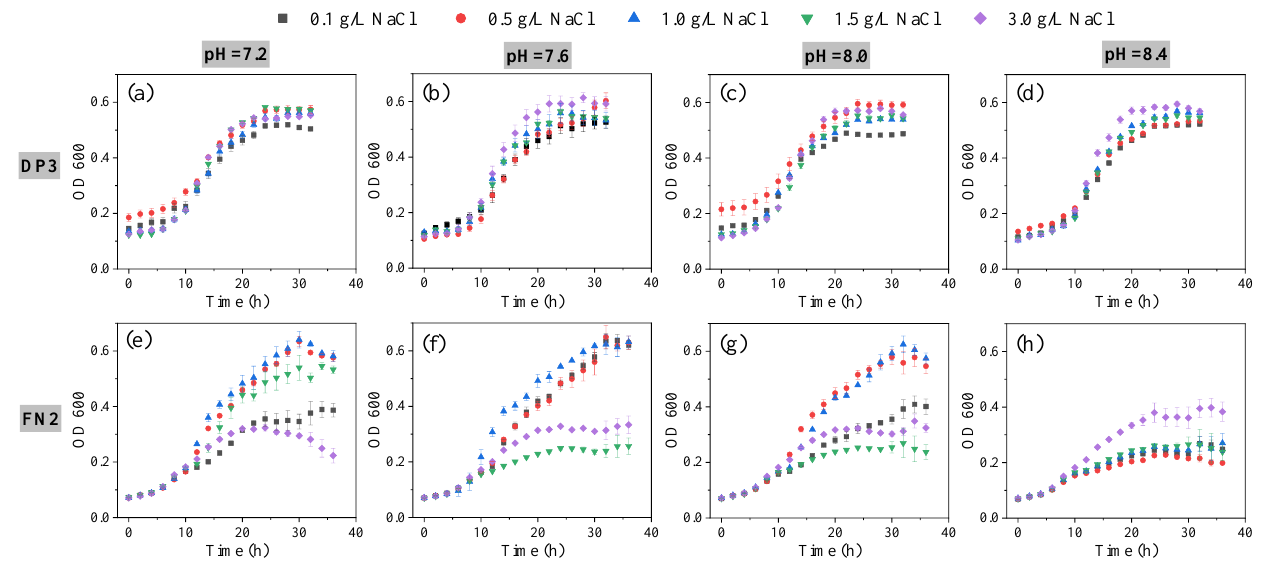
Figure 1. The growth curves of FN2 and DP3 under various salinity and alkalinity stresses. ( a ) DP3 under pH = 7.2; ( b ) DP3 under pH = 7.6; ( c ) DP3 under pH = 8.0; ( d ) DP3 under pH = 8.4; ( e ) FN2 under pH = 7.2; ( f ) FN2 under pH = 7.6; ( g ) FN2 under pH = 8.0 and ( h ) FN2 under pH = 8.4.